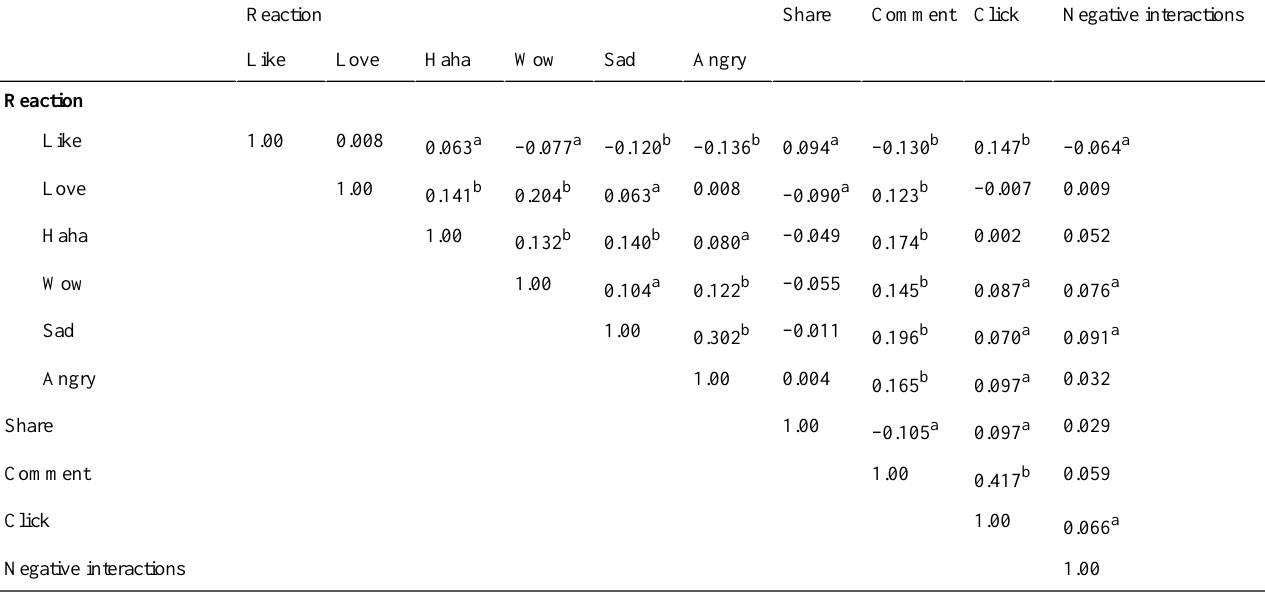
Negative interactionsClickCommentShareReaction